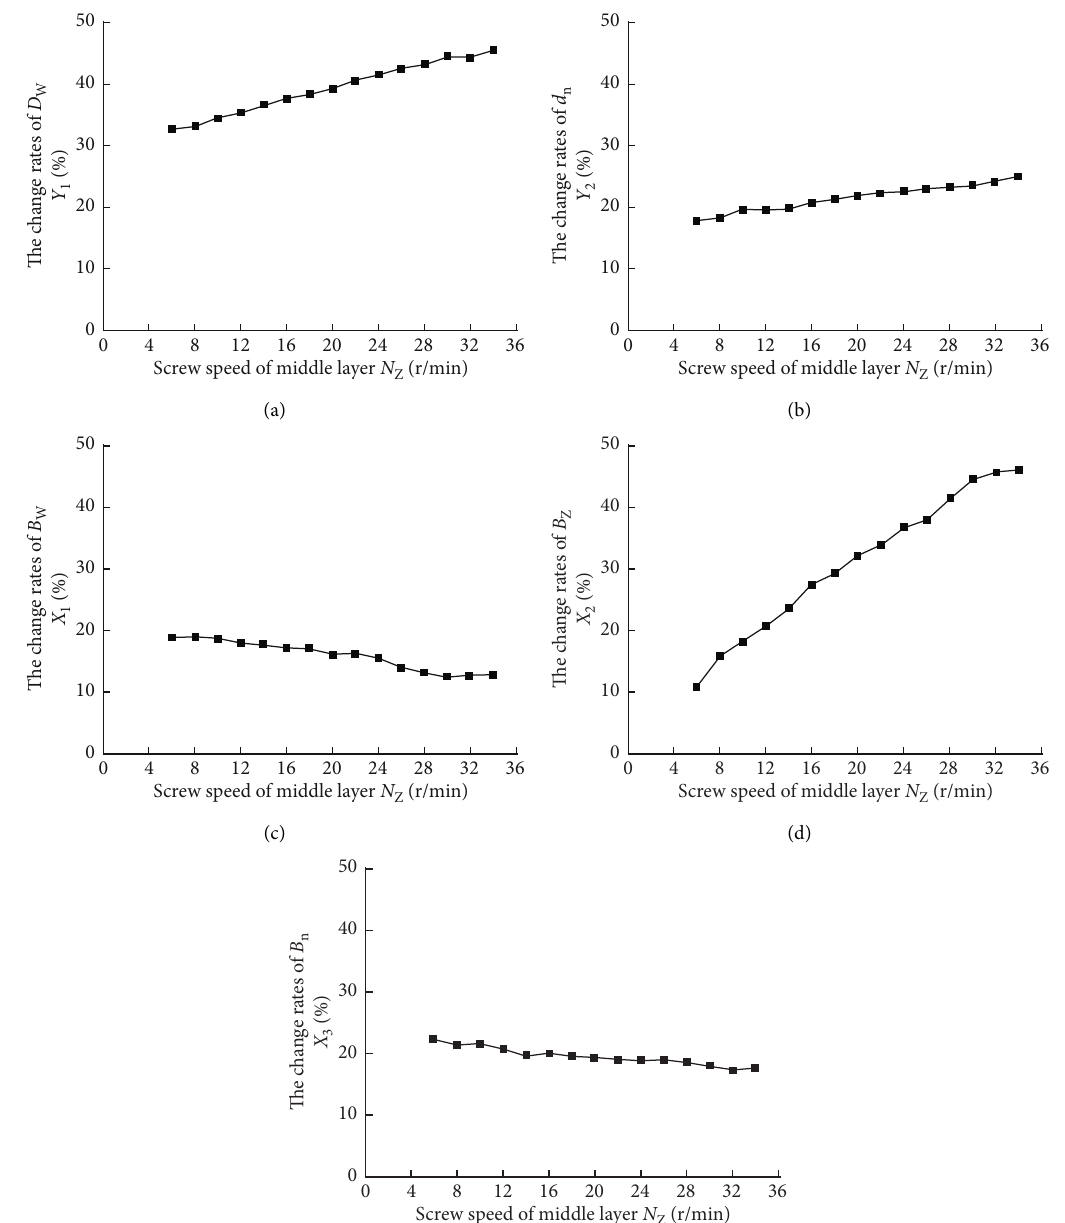
Figure 12: Diameter change rates ((a) outer and (b) inner diameter) and wall thickness change rates ((c) outer layer, (d) middle layer, and (e) inner layer wall thicknesses) of three-layered balloon catheters as a function of screw speed of the middle layer